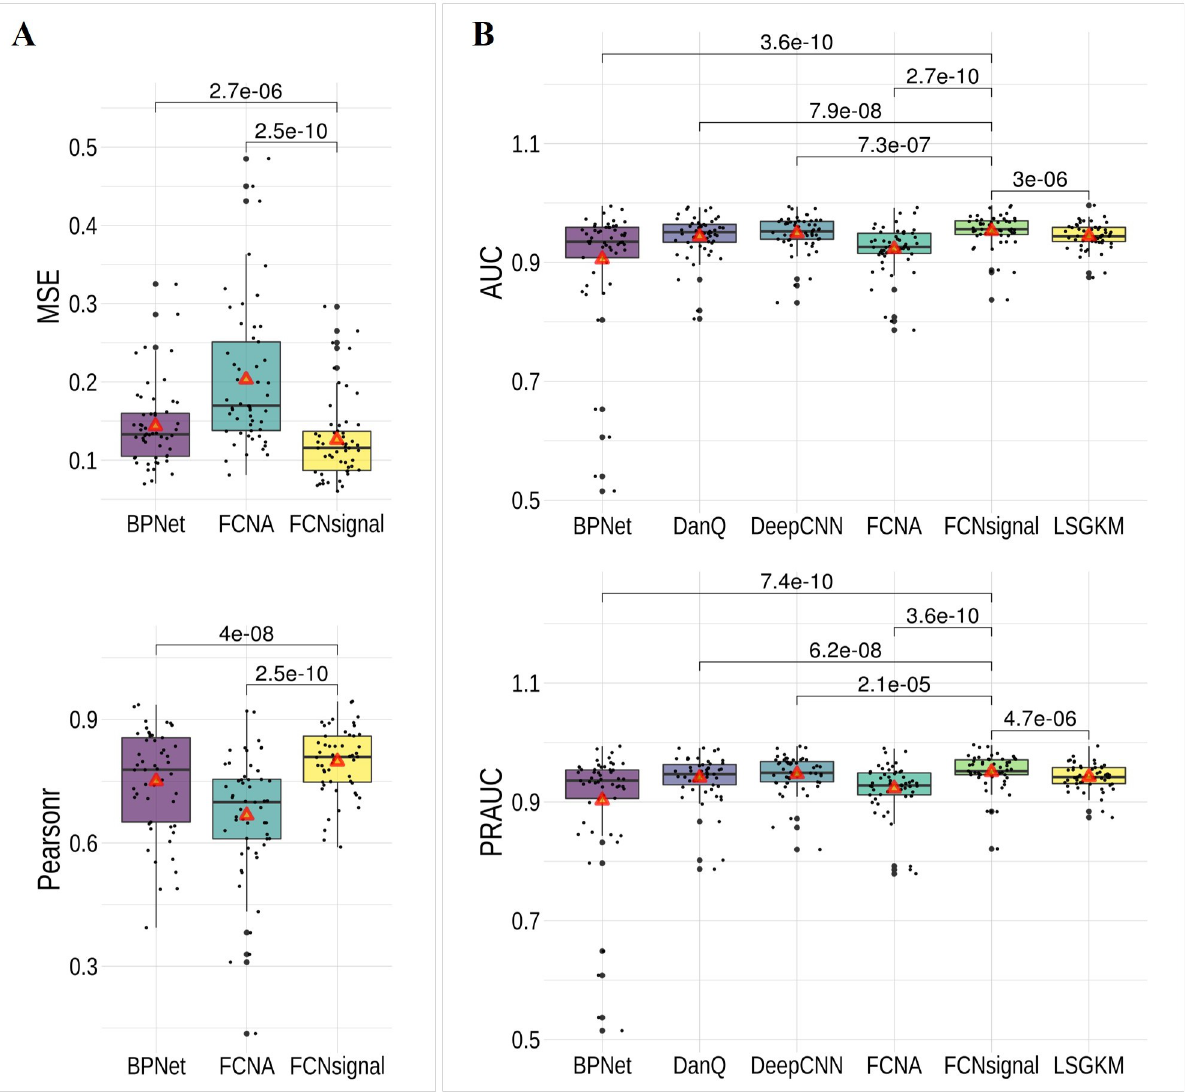
Fig 2. Performance comparison of FCNsignal and the competing methods on the 53 ChIP-seq datasets. (A) The MSE and Pearsonr values for BPNet, FCNA, and FCNsignal, and the Wilson’s test p-values (paired) of the two metrics between FCNsignal and the other two methods. (B) The AUC and PRAUC values for BPNet, DanQ, DeepCNN, FCNA, FCNsignal, and LSGKM, and the Wilson’s test p-values (paired) of the two metrics between FCNsignal and the other five methods. The red triangles represent the average values.